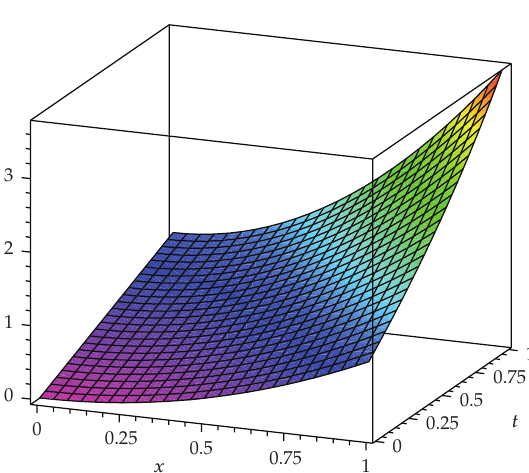
Figure 1: Exact solution of the nonlinear di ff usion problem on the interval (cid:5) 0 , 1 (cid:6) .